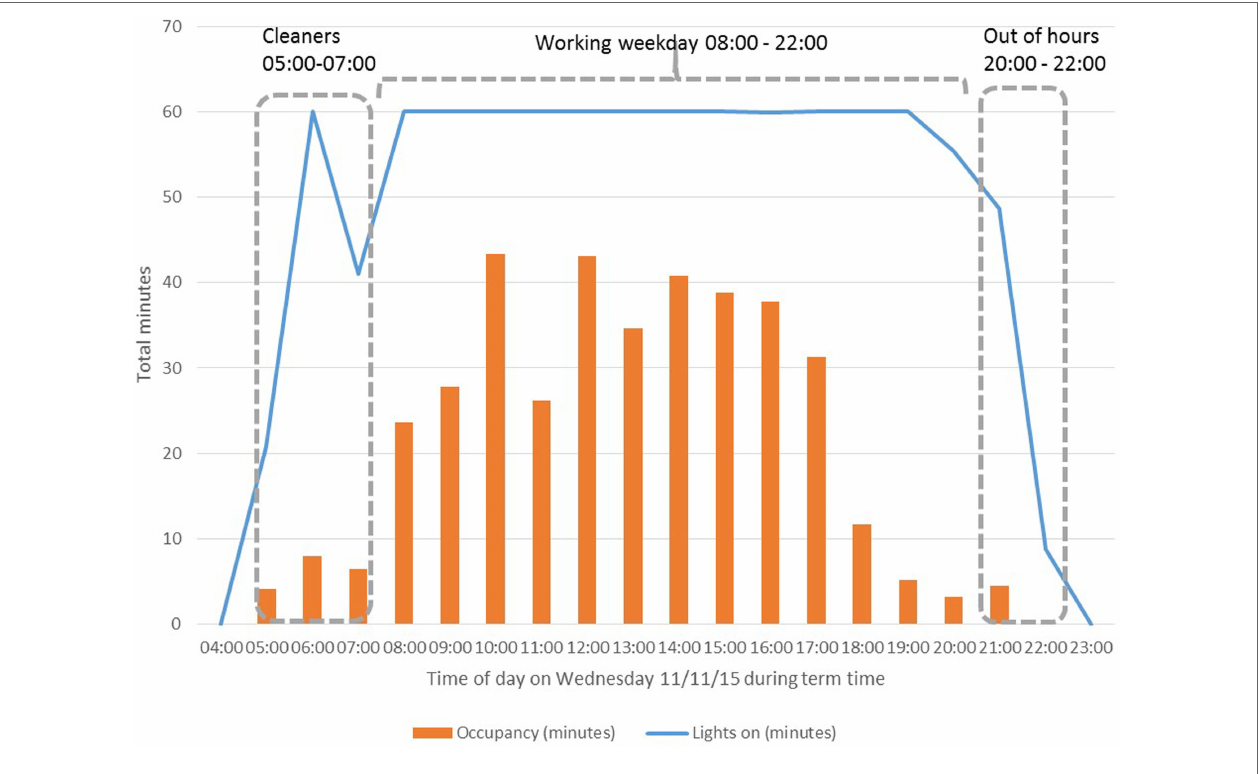
FigUre 3 | Typical term time weekday lights on and occupancy profiles: humanities 1 corridor at location 1 where installed ceiling lighting is controlled by ultrasonic sensors (rather than the timer).